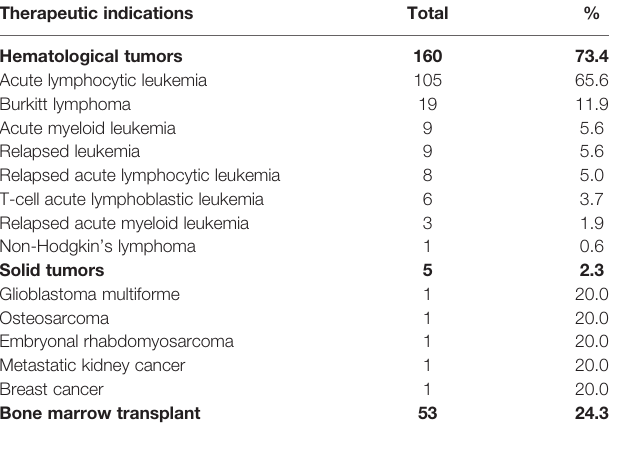
TABLE 3 | Number of non-off-label ICSRs with an antineoplastic protocols as suspected drugs distributed for the speci fi c therapeutic indication in the setting of the Campania spontaneous reporting system — January 2013 to September 2019.